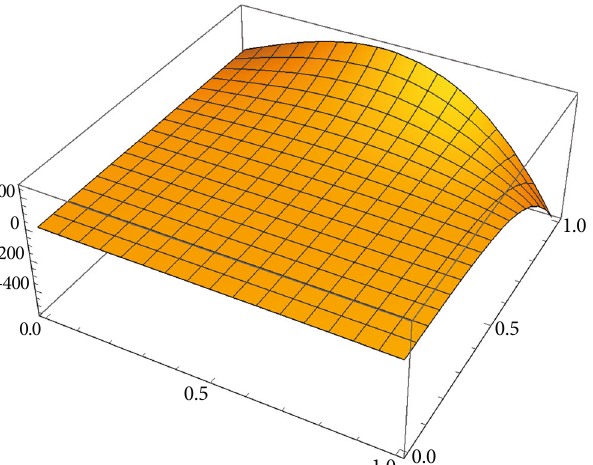
Figure 8: Approximate solution for Example